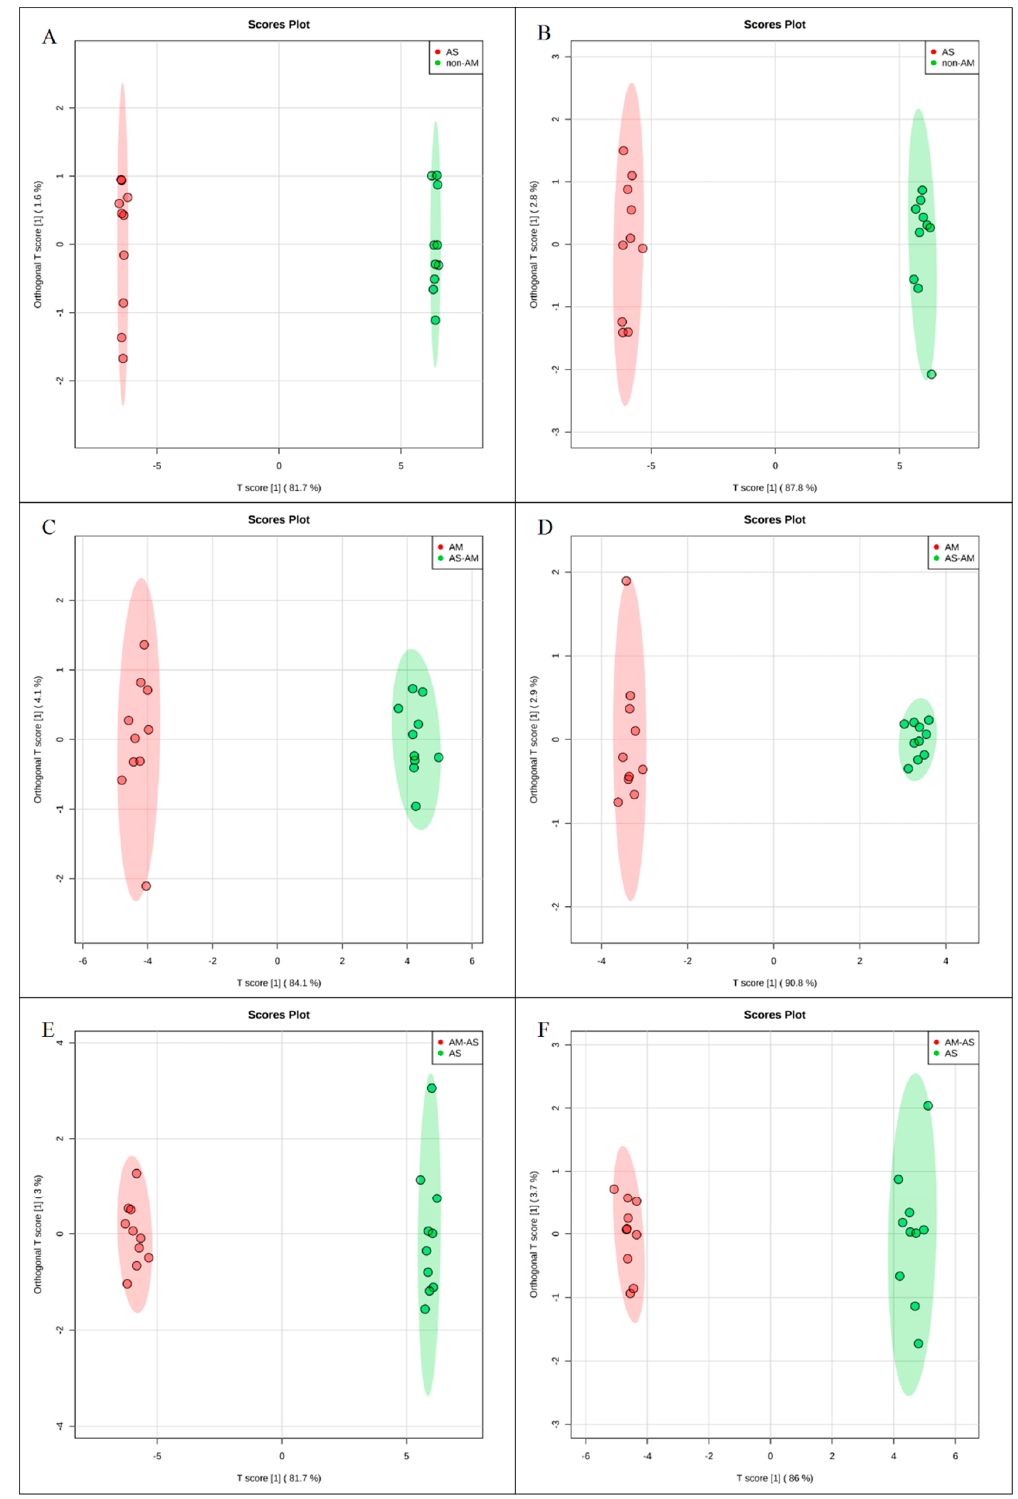
Figure 3. Orthogonal projections to latent structures ‐ discriminate analysis (OPLS ‐ DA) score plots of metabolic profiles in non ‐ AM seedlings in response to alkali stress ( A , B ), AM seedlings in response to alkali stress ( C , D ) and comparison in non ‐ AM seedlings and AM seedlings under alkali stress ( E , F ) in positive ( A , C , E ) and negative modes ( B , D , F ).